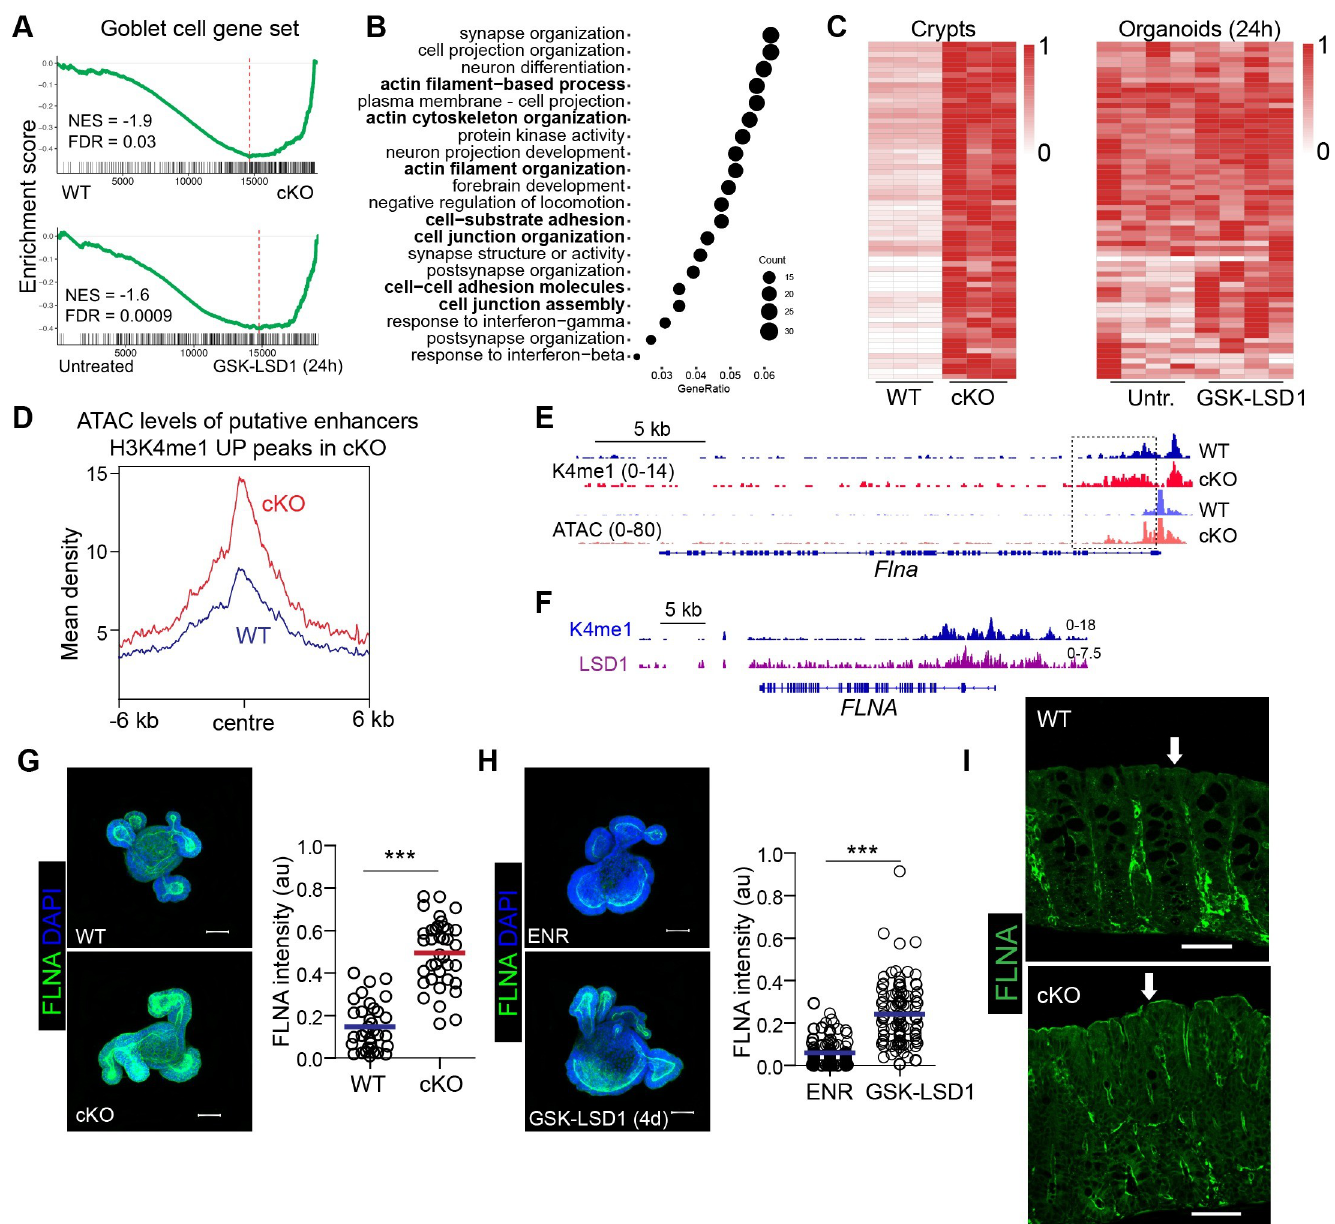
Fig 6. LSD1 epigenetically controls modulators of the cytoskeleton. (A) Application of GSEA of a goblet cell gene set in WT and cKO small intestine RNA seq, and untreated vs GSK-LSD1 (24h) treated organoids RNA-seq data. (B) Top 500 genes upregulated in cKO crypts were selected and unbiased association with the top 20 GO terms is displayed. ( C) Genes taken from in 6B bold-selected GO terms are displayed in a heatmap using Transcripts Per Million (TPM) values scaled to the max of the gene comparing WT and cKO crypts (left) and untreated and GSK-LSD1 (24h) treated organoids (right). (D) Mean ATAC signal of normalized peak density surrounding previously identified H3K4me1 peaks that are significantly up in cKO crypts compared to WT crypts. Representative graph from n = 2. (E) Representative Integrative Genomics Viewer ( IGV) tracks of H3K4me1 and ATAC signal at the Flna locus (n = 2). (F) IGV tracks of H3K4me1 and LSD1 levels at the FLNA locus in a human cancer cell line. (G) Representative confocal images of FILAMIN A (FLNA) stained in WT and cKO organoids. Quantification of FLNA intensity in WT and cKO organoids. (H) WT organoids were untreated (ENR) or treated (GSK-LSD1- 5 μ M) for 4 days and then stained for FLNA (green). DAPI was used as a counter stain (blue). Scale bar = 50 μ m Organoids were quantified for FLNA fluorescent intensity. (I) FLNA staining in paraffin embedded colon sections of naive WT and cKO mice. White Arrow indicates the increased FLNA expression on the apical side of colonic crypts. Scale bar = 50 μ m. Unpaired Student’s t test was performed to observe significant differences. ��� P �